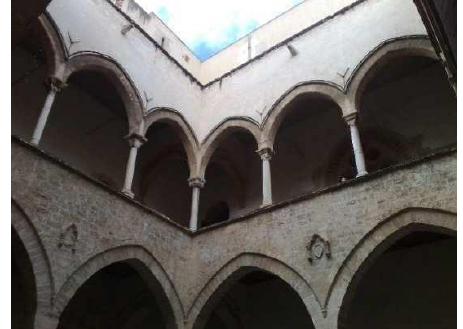
Figure 2. First floor of the courtyard, marble